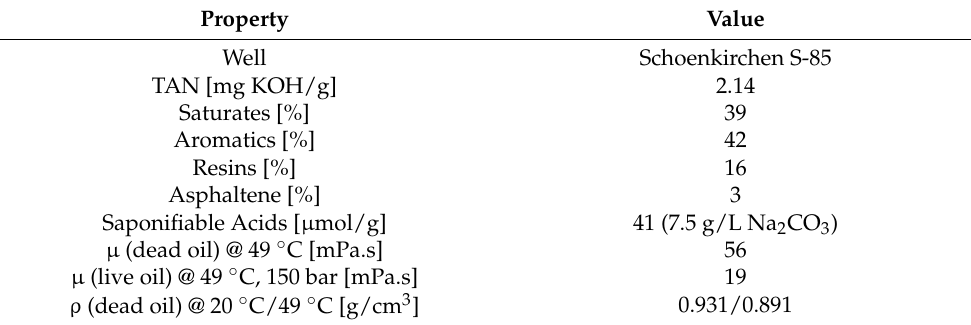
Table 1. Composition of crude oils used in this work from the 8 TH reservoir.